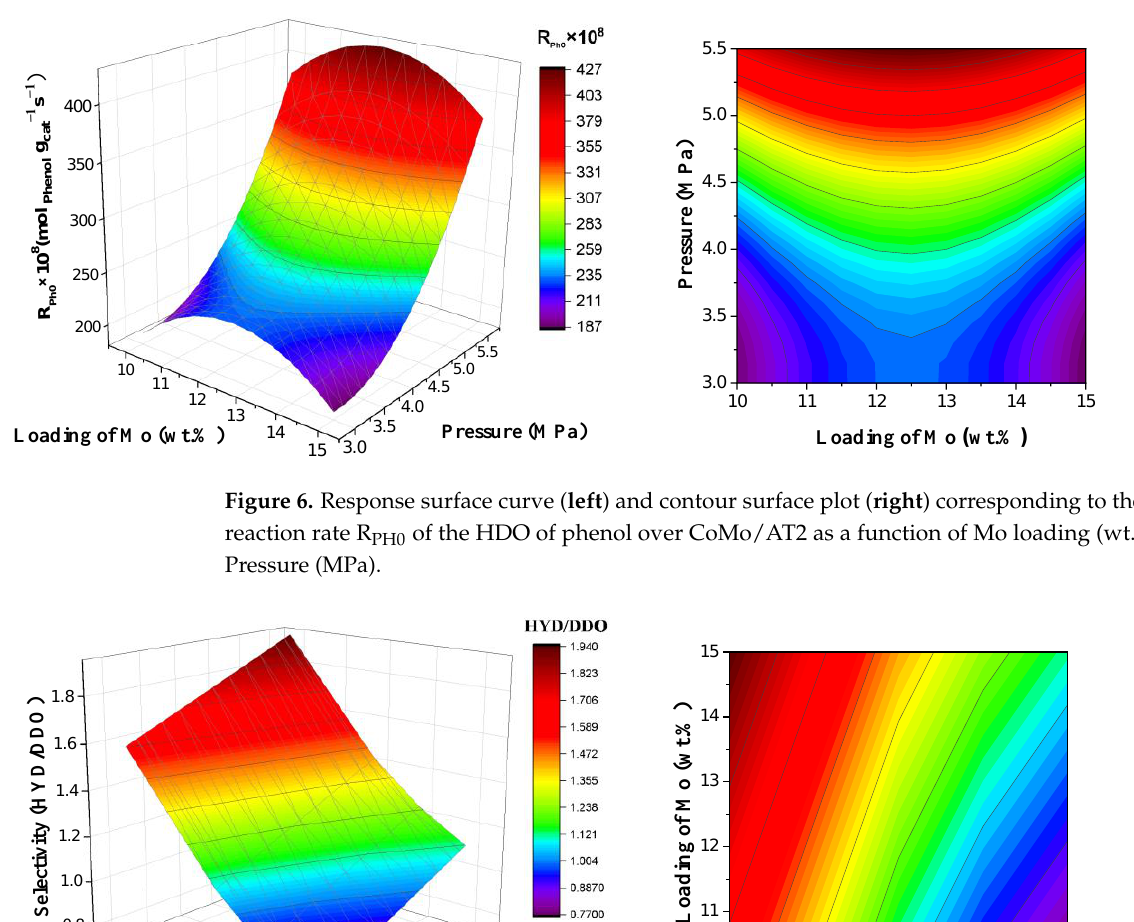
Table 1. The effect of operational temperature on the initial reaction rate of phenol using a Co- MoS/AT2 material with a Mo loading of 12 wt.% and operational pressure of 5.5 MPa. Temperature